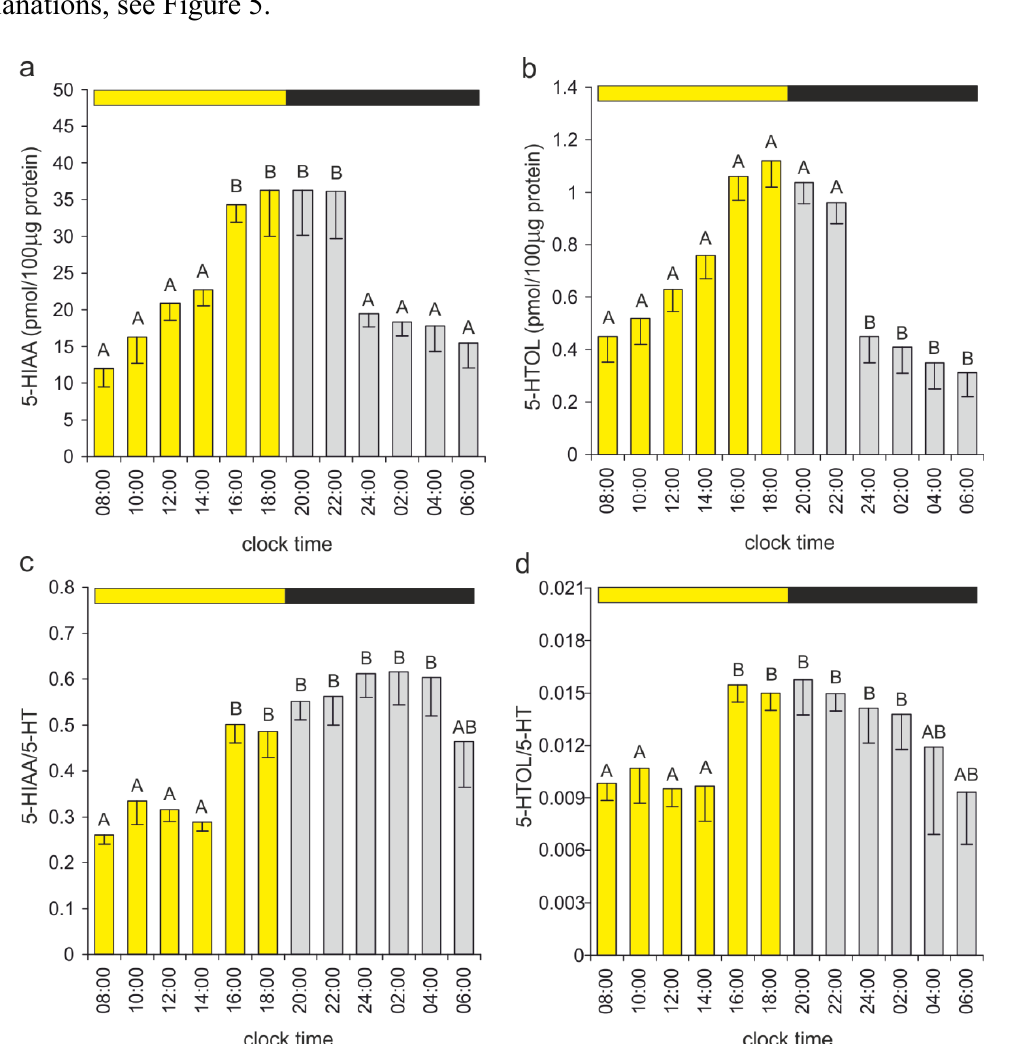
Figure 6. Indoles formed by the oxidative deamination of 5-HT. ( a , b ) The 5-HIAA and 5-HTOL contents and ( c , d ) the 5-HIAA/5-HT and 5-HTOL/5-HT ratios in the duck pineal organs taken at two-hour intervals over a daily cycle (means and standard errors, n = 5). For explanations, see Figure